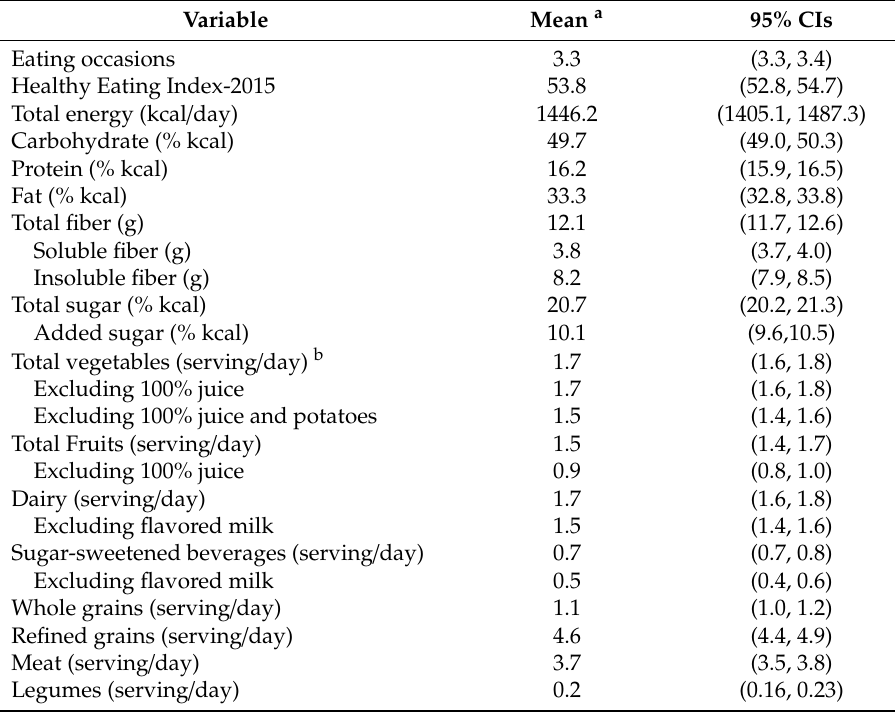
Table 2. Dietary characteristics of the analytic sample ( n =